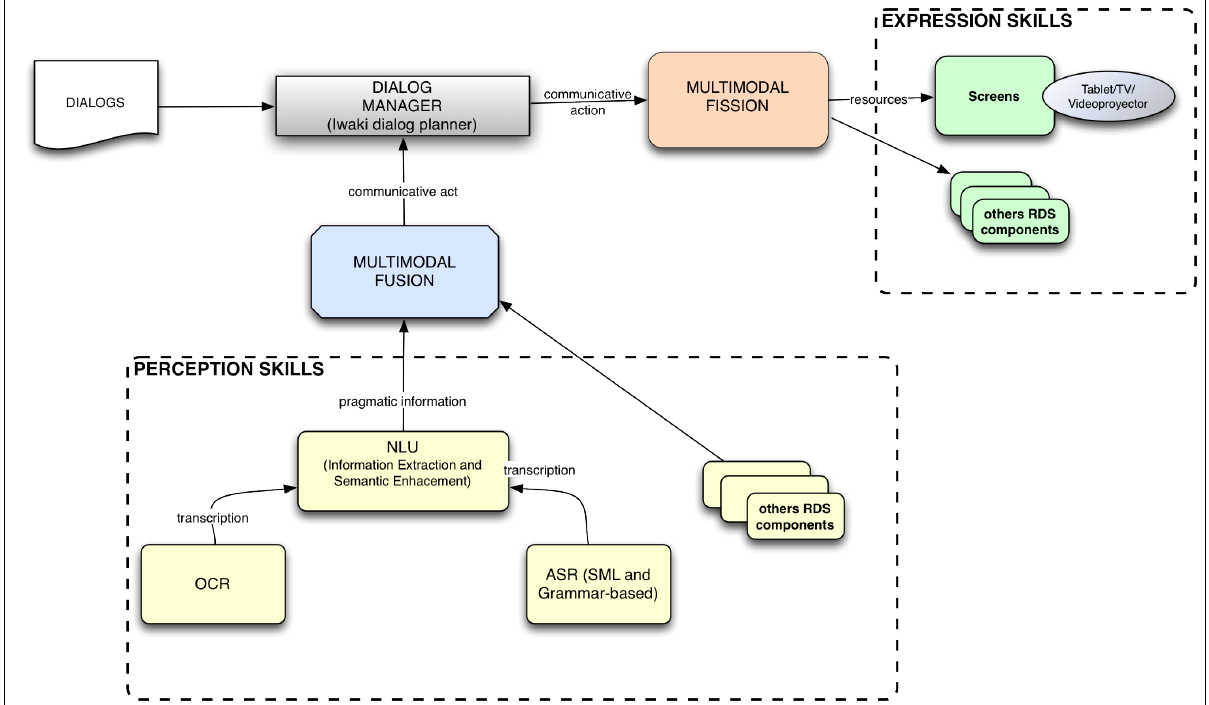
Figure 3. Sketch of the augmented robotic dialog system (ARDS). The system includes new components not in the RDS, information extraction and information enrichment, and a new component for managing a screen as a communicative mode. Below the text recognition component (OCR) and the speech recognition (ASR) component are represented. ASR can work in two different modes: a statistical language model (no grammatical restrictions) or a grammar-based mode.